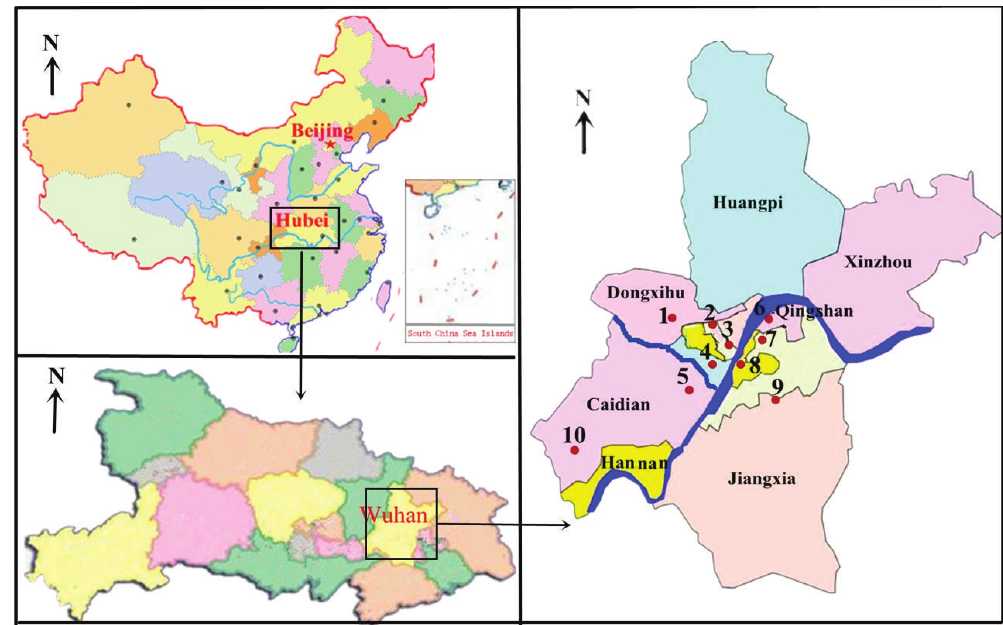
Figure 1: Map of Wuhan with districts and national-level ambient air monitoring